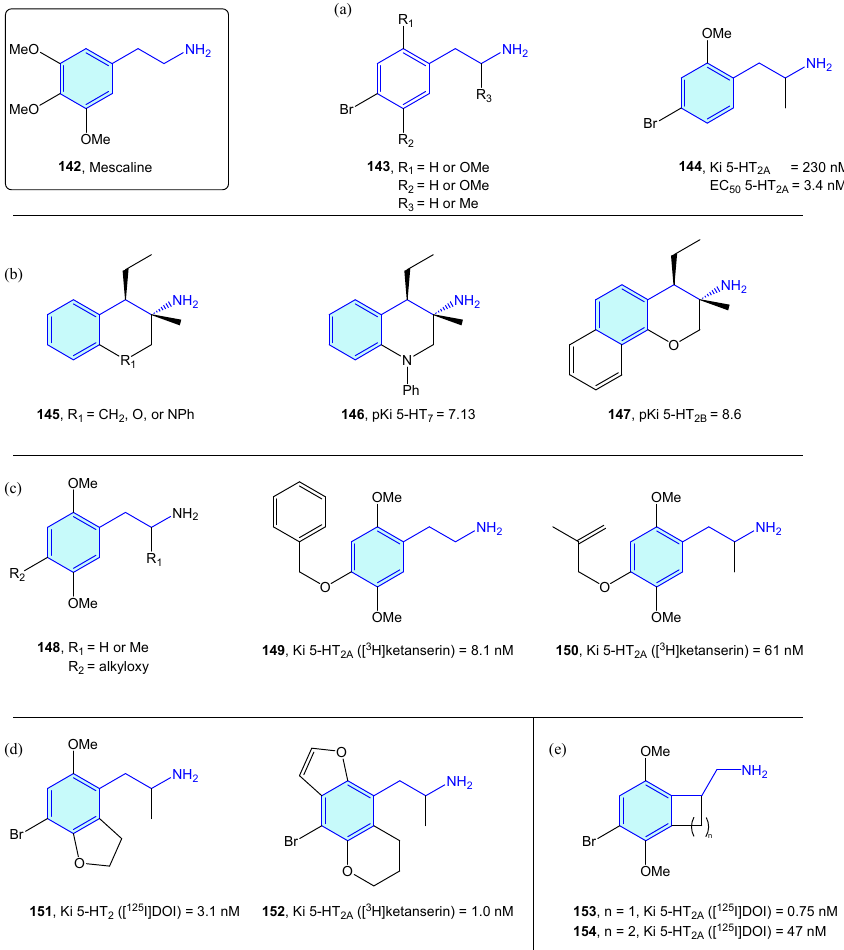
Figure 18 . 2-Phenethylamines with 5-HT receptor activity. Figure 18. 2‑Phenethylamines with 5‑HT receptor